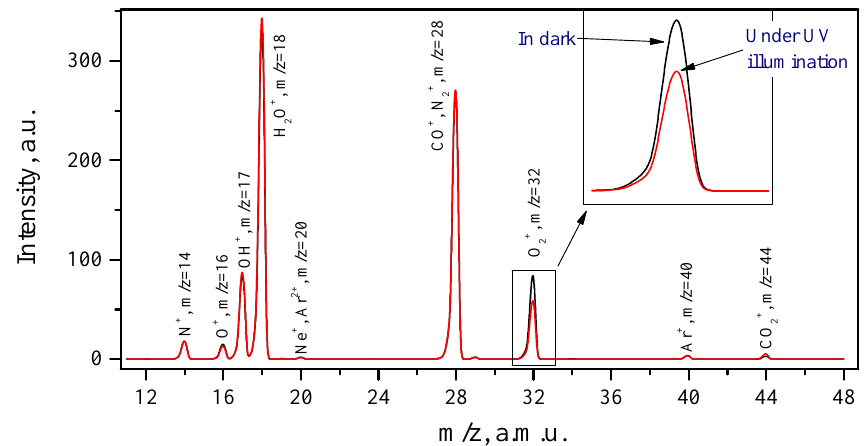
Figure 8. Mass spectrum of the carrier gas leaving the cell with loaded ZnO tablets under stationary dark conditions (black line) and after 9 min of turning on UV radiation (red